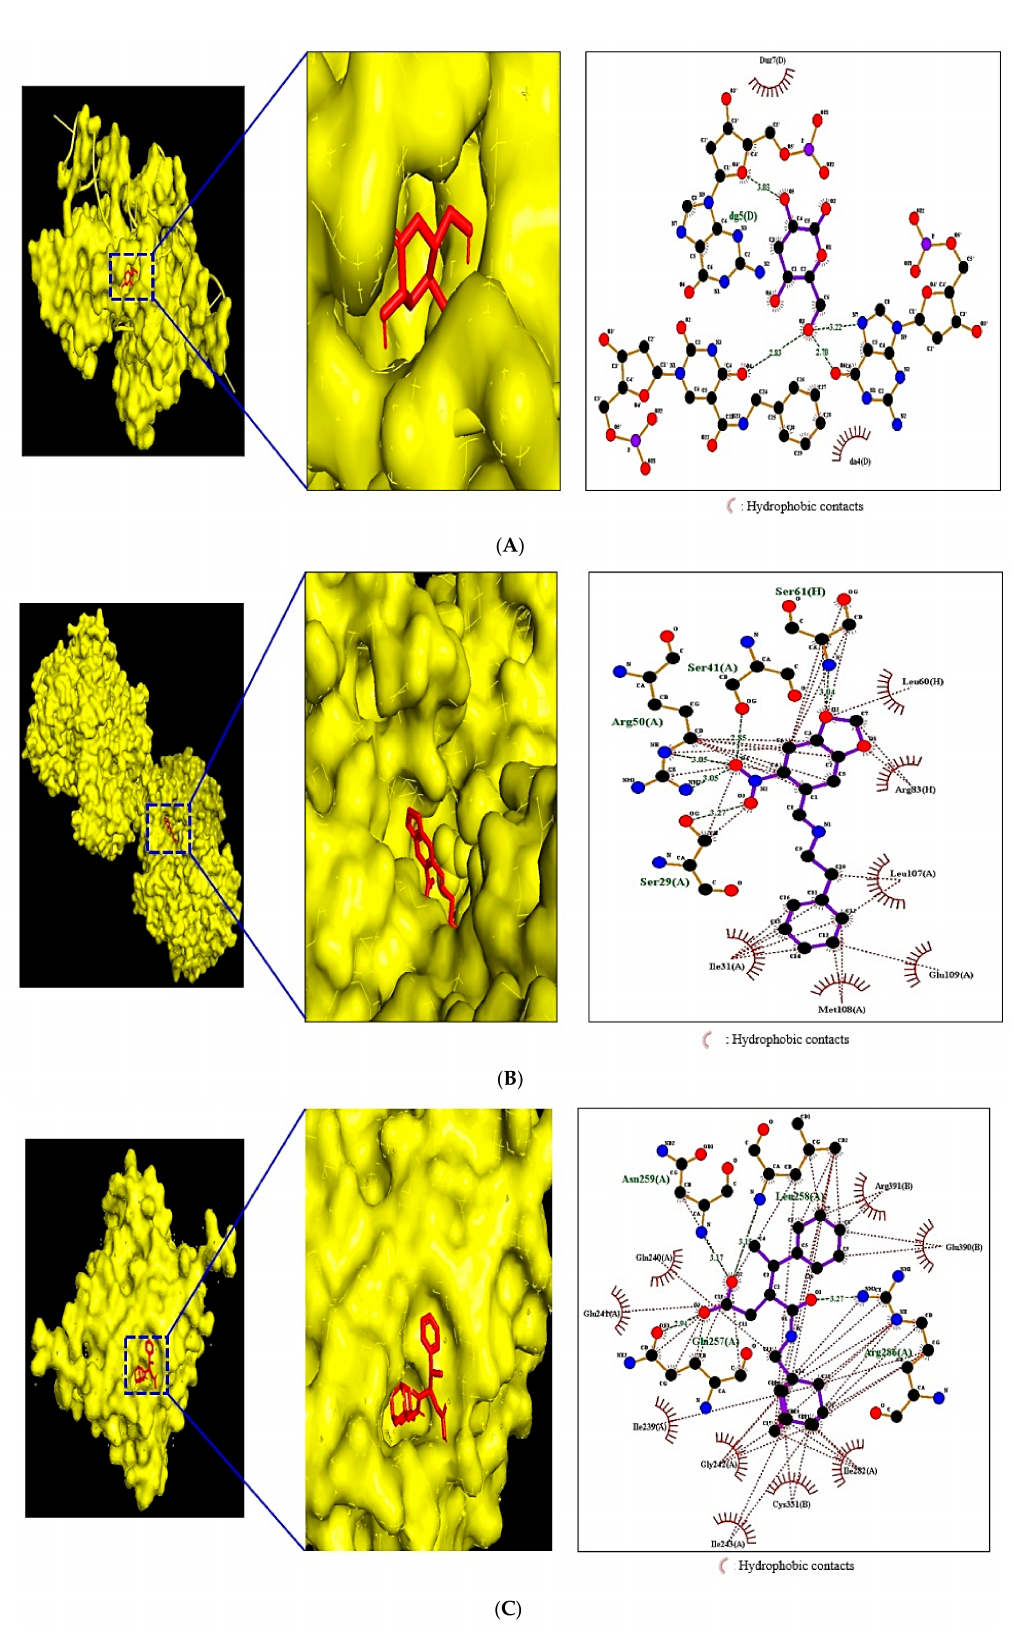
Figure 8. ( A ) MDT of three, 3,5-Dihydroxy-6-(hydroxymethyl) oxan-2-one on IL6 (PDB ID: 4NI9). ( B ) MDT of 4- dehydroxy-N-(4, 5-methylenedioxy- 2- nitrobenzylidene) tyramine on MAPK1 (PDB ID: 4IZ5). ( C ) MDT of pentanoic acid, 3-[(adamantan-1-ylmethyl) carbamoyl]-4-phenyl- on CASP1 (PDB ID: